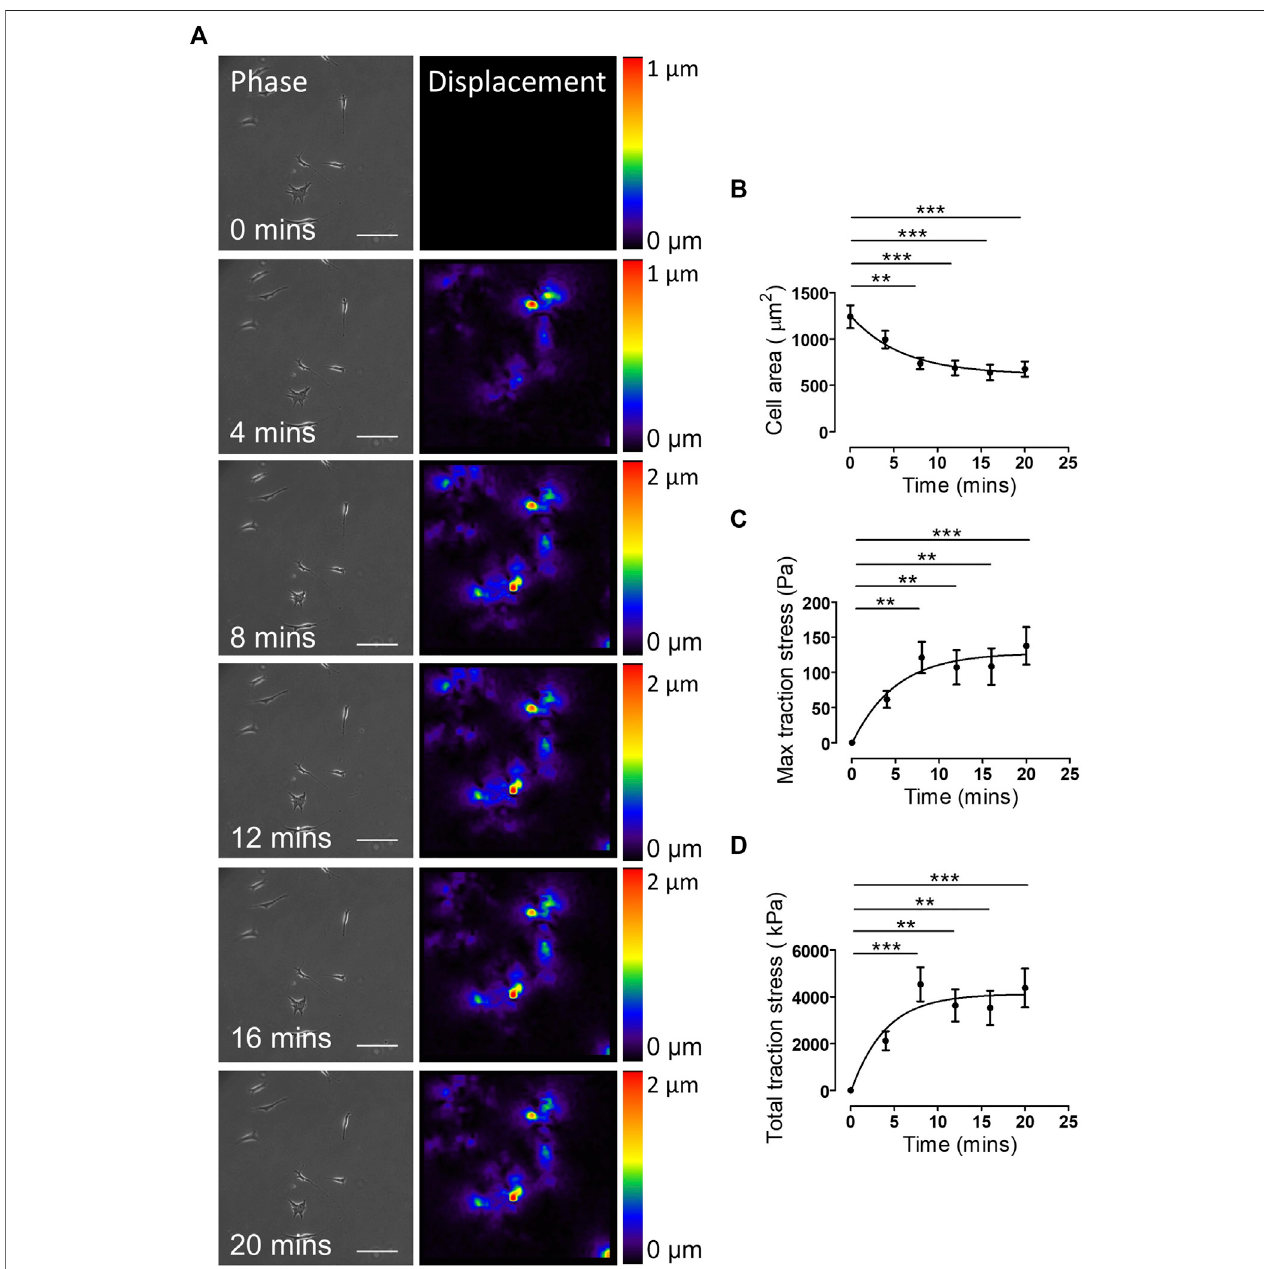
FIGURE 2 | Traction stress generation correlates with decreased VSMC area following angiotensin II stimulation. (A) Representative phase images and bead displacement heat maps of isolated VSMCs grown on 12 kPa polyacrylamide hydrogels and stimulated with angiotensin II over a 20 min time course. Scale bar = 100 μ m. Displacement heat maps were generated by comparing the bead displacement for each time point to their initial positions at t = 0, as such there is no displacement at t = 0. (B) Isolated VSMC area, (C) maximum traction stress and (D) total traction stress generated at each time point compared to t = 0. Graphs represent the combined data from 3 independent experiments, with measurements taken from 35 VSMCs. (** = p < 0.01), (*** = p < 0.001).